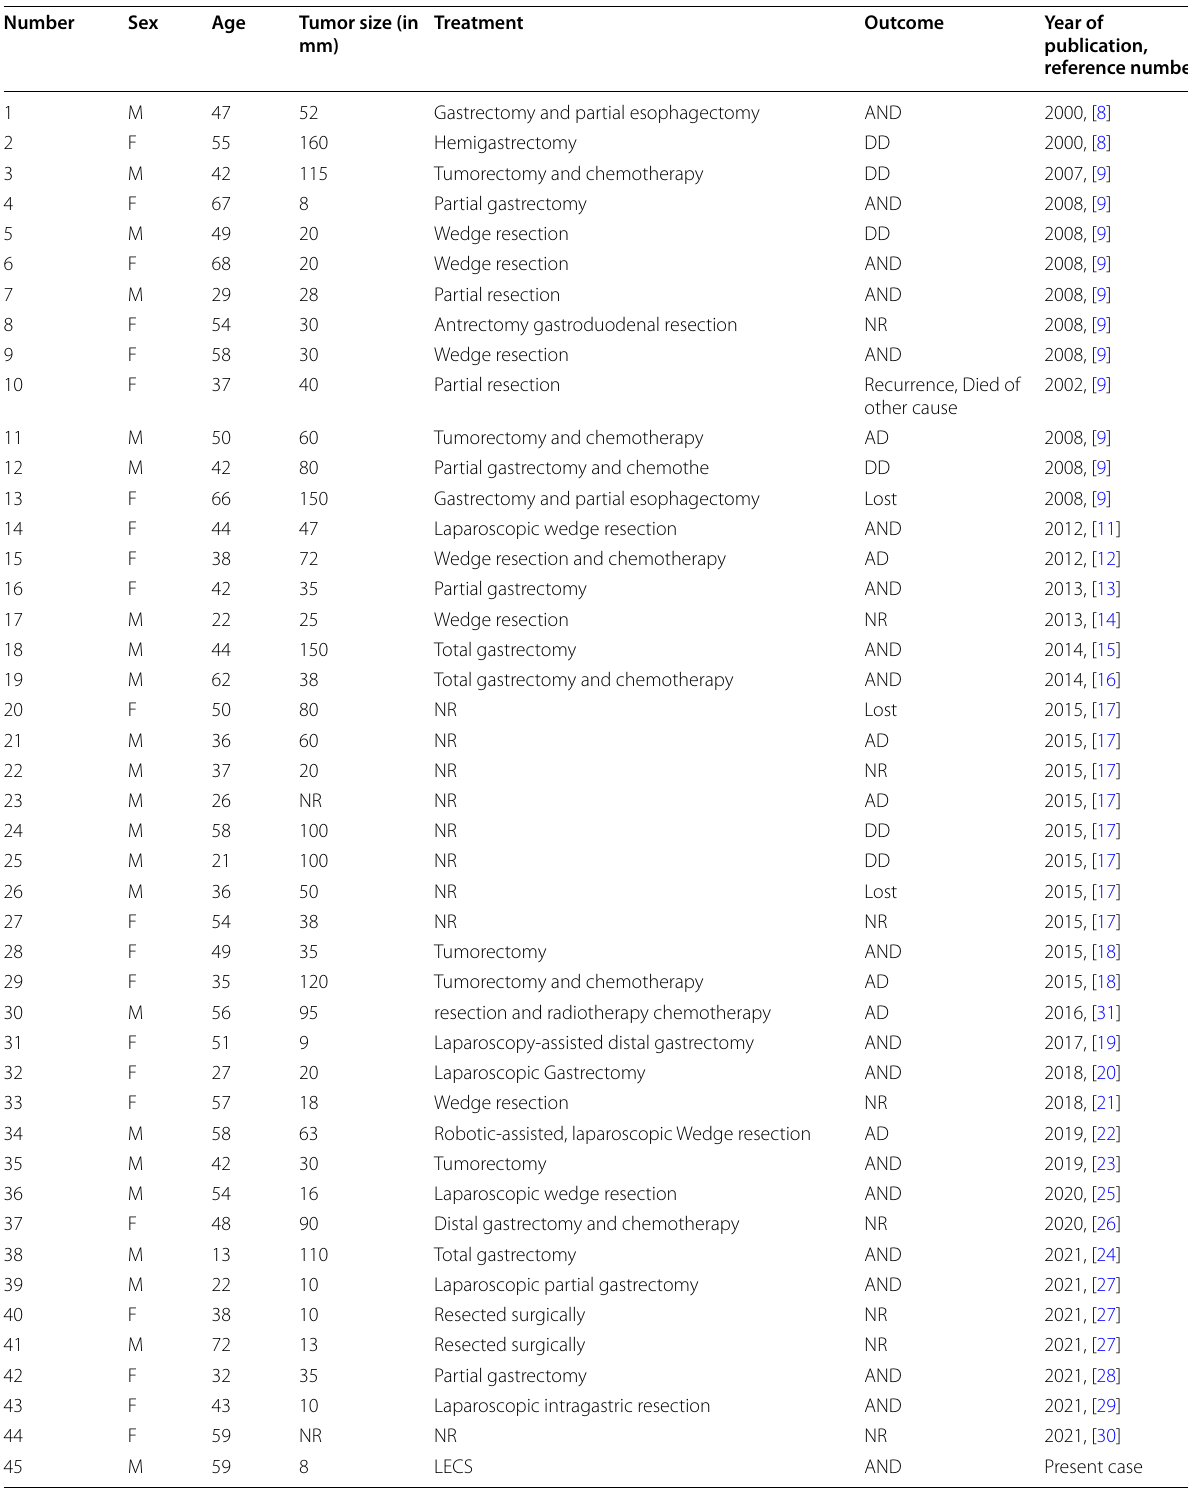
AND, alive with no evidence of disease; AD, alive with disease; DD, died of disease, NR, not reported; LECS, laparoscopic endoscopic cooperative